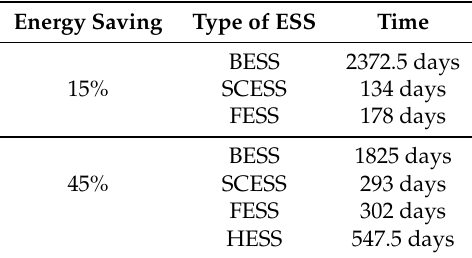
Table 1. Benefit–Cost analysis.